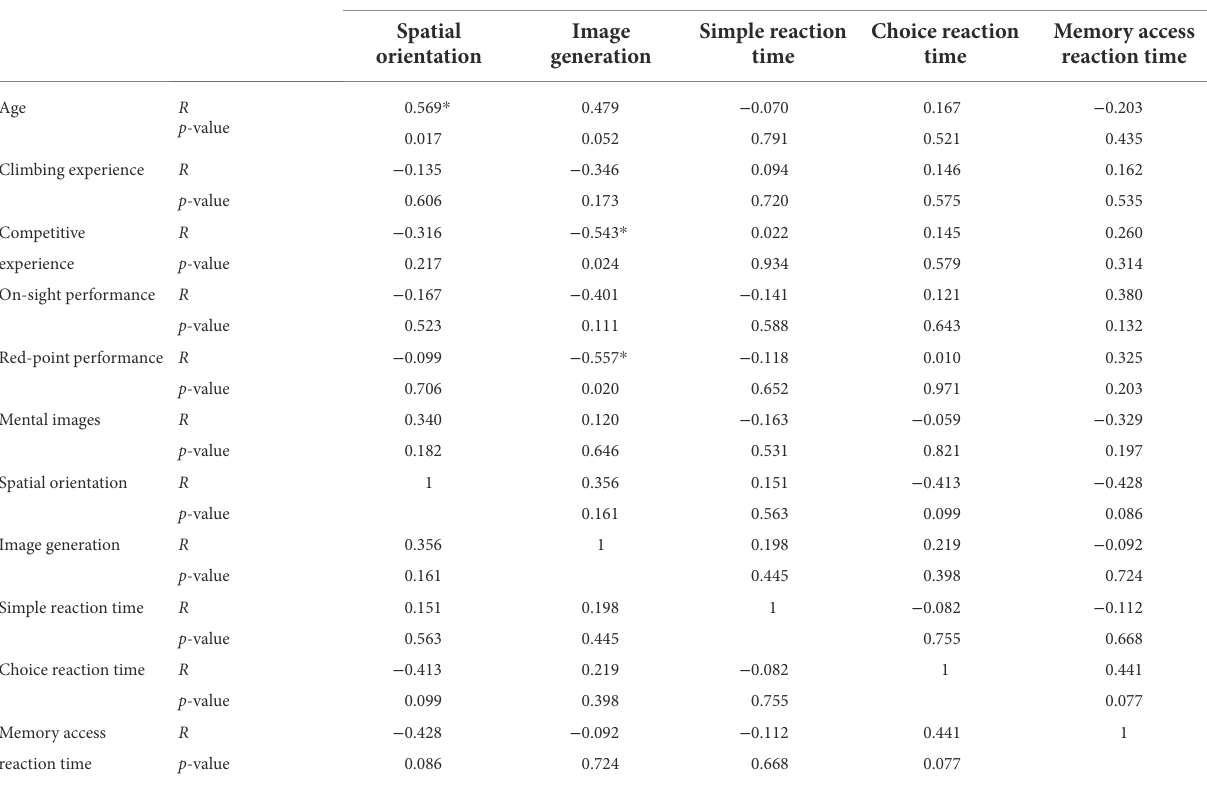
TABLE 3 Correlation